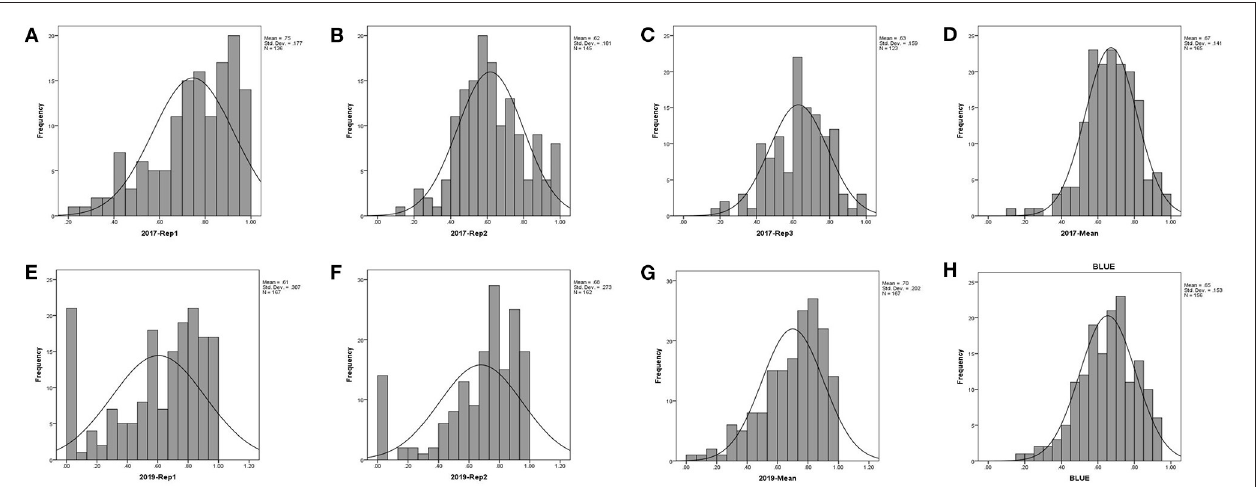
FIGURE 1 | Histogram of the stalk rot disease index for 165 maize inbred lines. (A–D) repeat 1, repeat 2, repeat 3, and mean in 2017; (E–G) repeat 1, repeat 2, and mean in 2019, respectively; (H) is the BLUE value in 2 years).